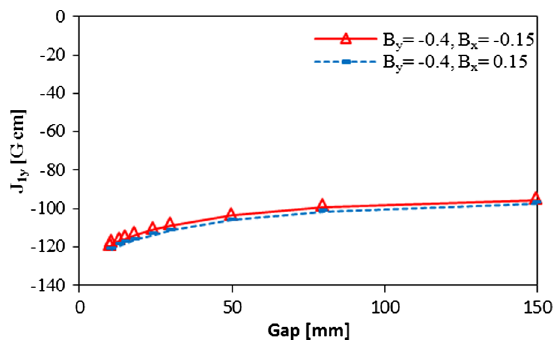
FIG. 9. Comparison B y ¼ − 0 . 4 , B x ¼ − 0 . 15 and B y ¼ − 0 . 4 , B ¼ 0 .15 for APS27 #5s with frame (R ADIA x